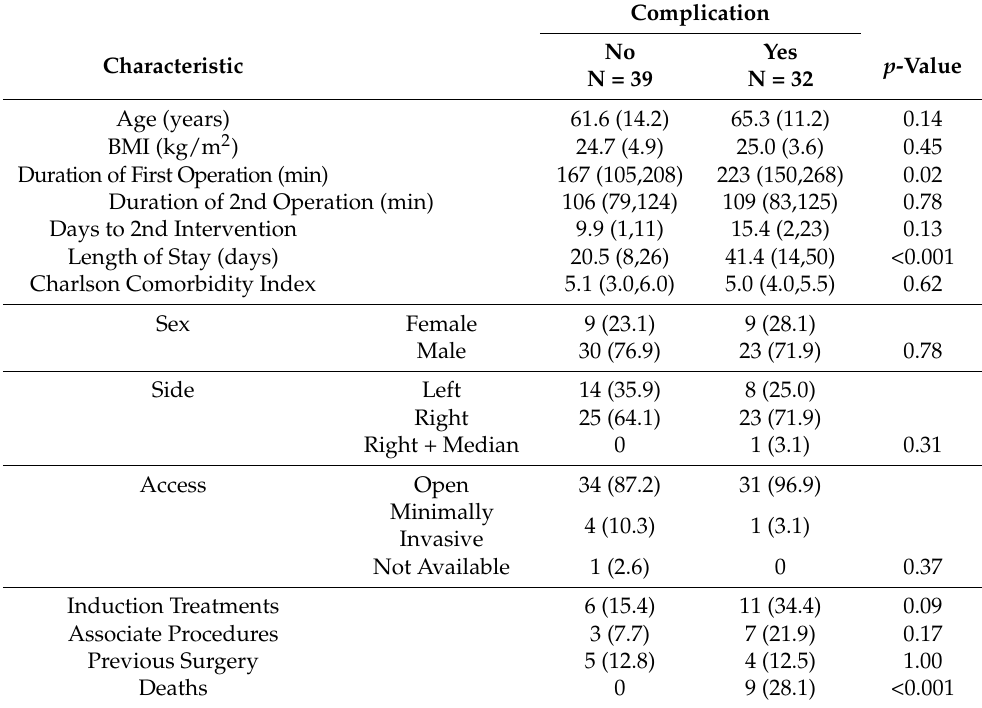
Table 6. Patients characteristics and treatments by complication after reoperation summary statistics.